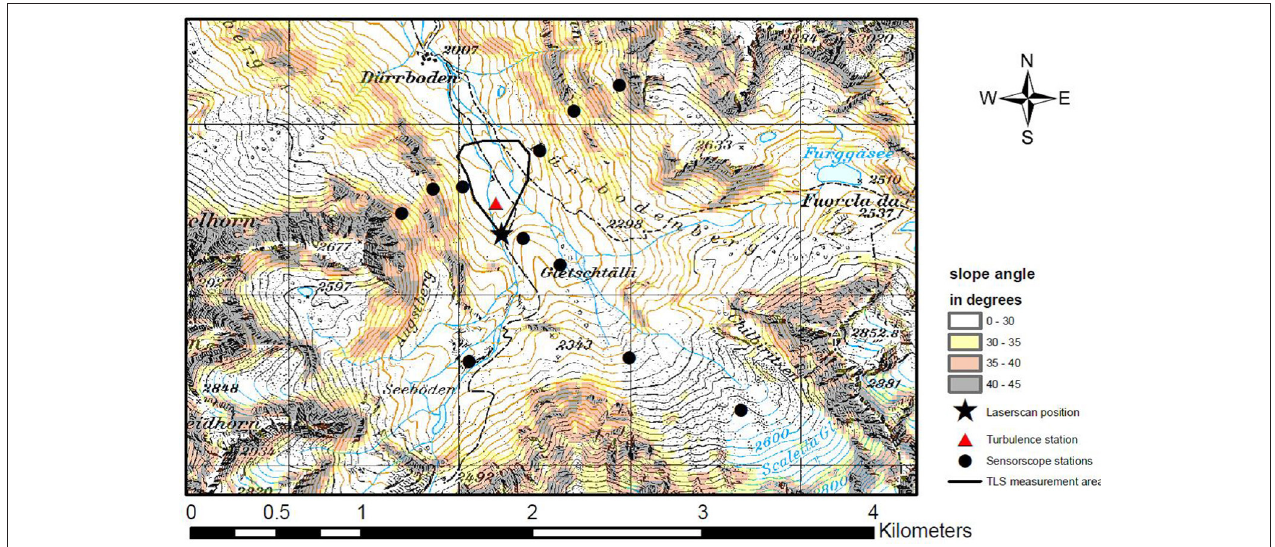
FIGURE 1 | Measurement setup at the Gletschboden area in the upper Dischma valley. Mobile meteorological stations (black circle), Terrestrial laser scanning position (black asterisk), turbulence station (red triangle) and the laser scanner measurement area (solid black line) are shown.